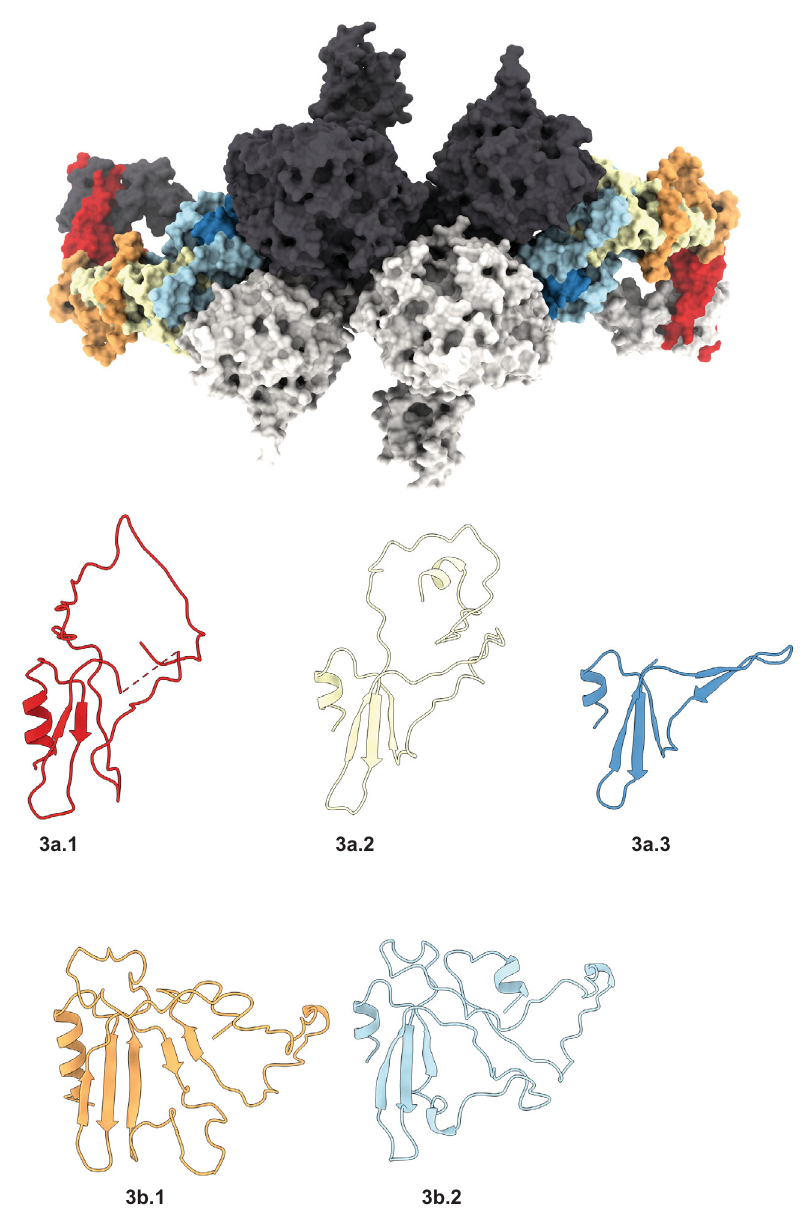
Fig. 5 Type 3 repeats. (Top) Surface representation of the hTG dimer with type 3 repeats colored as represented in the bottom panel; the other individual hTG structures within a monomer are highlighted charcoal and light gray. (Bottom) Ribbon representation of the aligned type 3